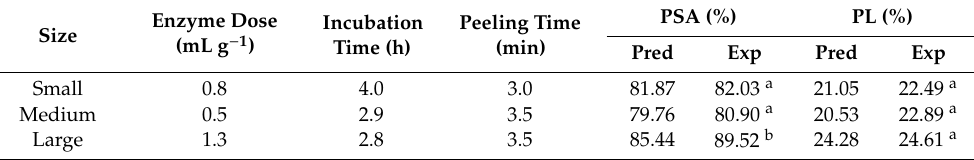
Table 7. Optimum operating conditions in terms of enzyme dose, incubation time and peeling time along with the measured (Exp) and predicted (Pred) values of the peeled surface area (PSA) and peel loss (PL) of small, medium and large size cassava